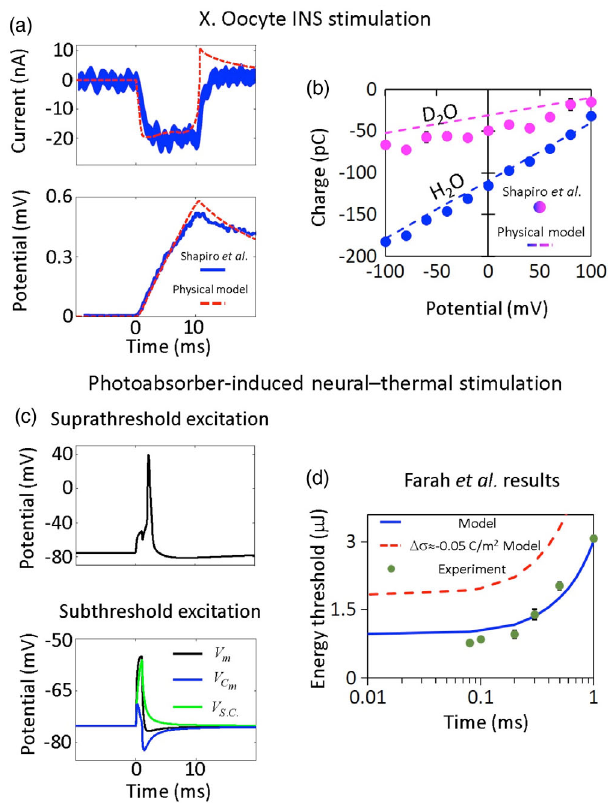
FIG. 4. Empirical cellular neurostimulation results versus model- based predictions. (a),(b) Predicted versus measured membrane currents, potentials, and induced charge, for 10 ms, 7.3 mJ INS stimulationof Xenopusoocyte inH 2 O-andD 2 O-basedextracellular media; illumination of 5% of the surface area assumed [16]. (c) Predicted somatic membrane potentials in a cortical pyramidal neuron stimulated by threshold and 90% subthreshold simulated 1 ms PAINTS transients. The membrane potential ( V m ) thermal response is dictated by surface charge- and capacitance-related potentials ( V and V Cm , respectively), where V Cm is also affected S : C. by the membrane ’ s charge dynamics. (d) Predicted versus empirical thresholds [Fig. 5(a) in Ref. [18]]. The constant α determined from the best fit was used to calculate the surface charge difference in rat cortical neurons (solid blue line, Δ σ ¼ σ i − σ o ¼ − 0 . 107 C = m 2 ); predictions for an alternative model ( Δ σ ¼ − 0 . 05 C = m 2 , dashed red line) are also shown for comparison. σ i ≈ − 0 . 12 C = m 2 and σ ≈ − 0 . 013 C = m 2 for V o Cm and V S : C. the calculation in (c). Error bars are (cid:1) s :